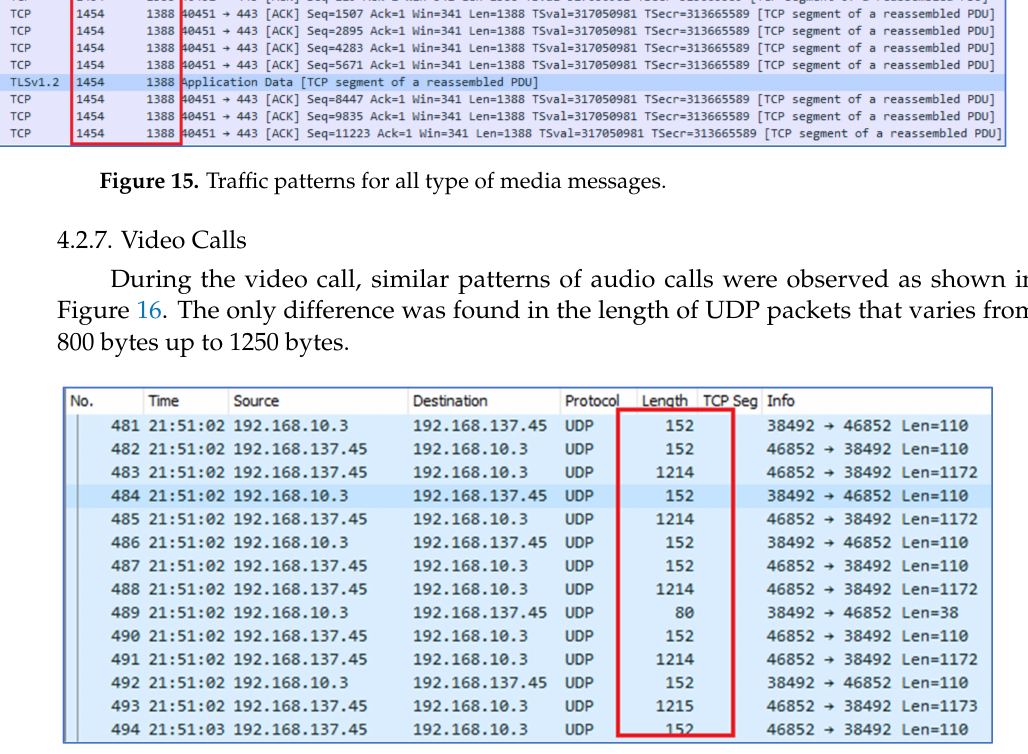
Figure 16. UDP traffic patterns for video